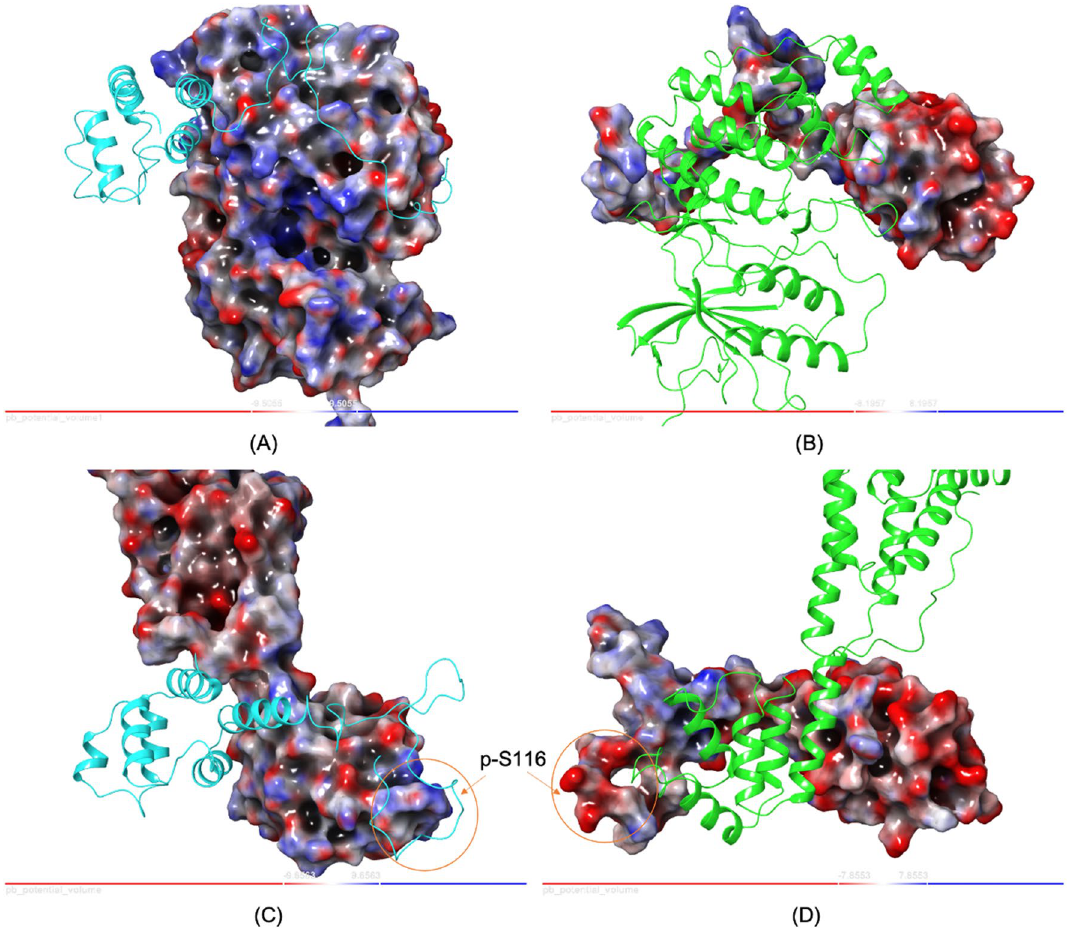
Figure 7. Poisson–Boltzmann Electrostatic Potential Surfaces (PB EPS) of PEA-15/ERK2 ( A , B ) and PEA-15pp/ FADD ( C , D ) complexes. ( A ) ERK2 is shown as EPS and PEA-15 as a ribbon in cyan. ( B ) PEA-15 is shown as EPS and ERK2 as a ribbon in green. The view in ( B ) is rotated 180° from ( A ). ( C ) FADD is shown as EPS and PEA-15pp as a ribbon in cyan. ( D ) PEA-15pp is shown as EPS and FADD as a ribbon in green. The view in ( D ) is rotated 180° from ( C ). On the EPS, negative charge is represented as red and positive charge as blue. Protein– protein interactions are largely electrostatic in nature. Note that in PEA-15pp/FADD interaction, there is a strong electrostatic interaction between negatively charged p-S116 on PEA-15pp and the positive patch formed by R34 and R38 on FADD, which determines the binding specificity of PEA-15. The molecular structures and the EPS were generated using Maestro version 2021-2 (https:// www. schro dinger. com/ produ cts/ maest